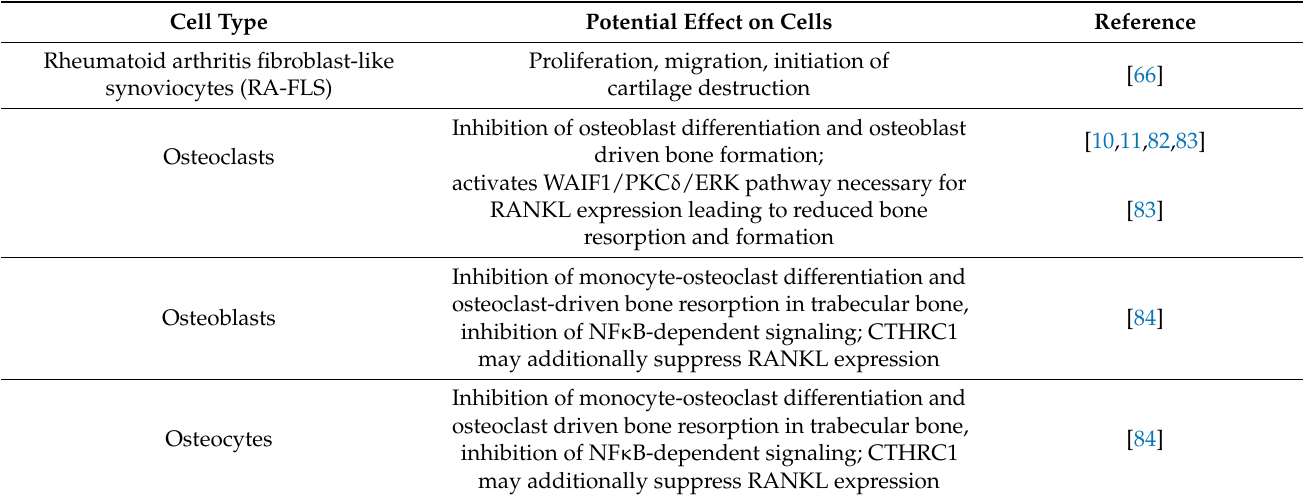
Table 1. Potential cellular sources of CTHRC1 and effects within the